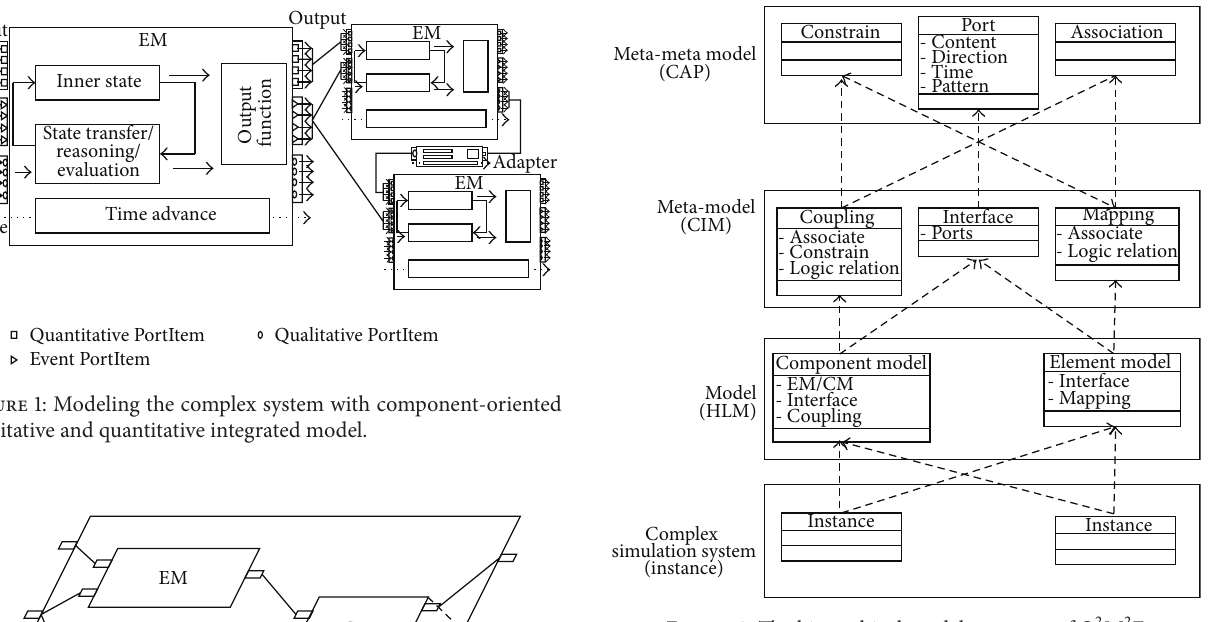
Figure 3: The hierarchical model structure of Q 2 M 2